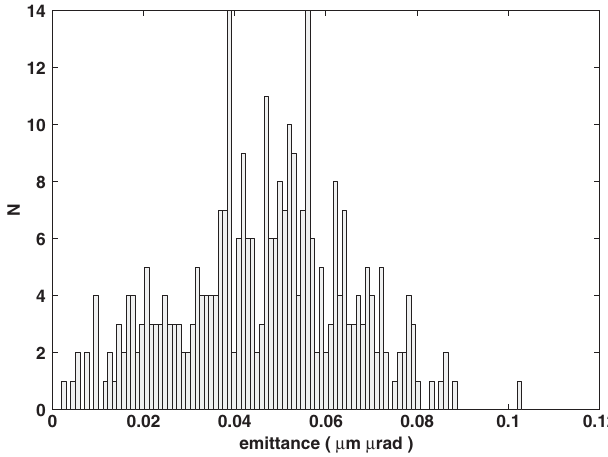
FIG. 2. Example of a direct least-squares emittance fit (35% error level, 4D ILC optics). The true emittance is 0 : 079 (cid:3) m (cid:8) (cid:3) rad